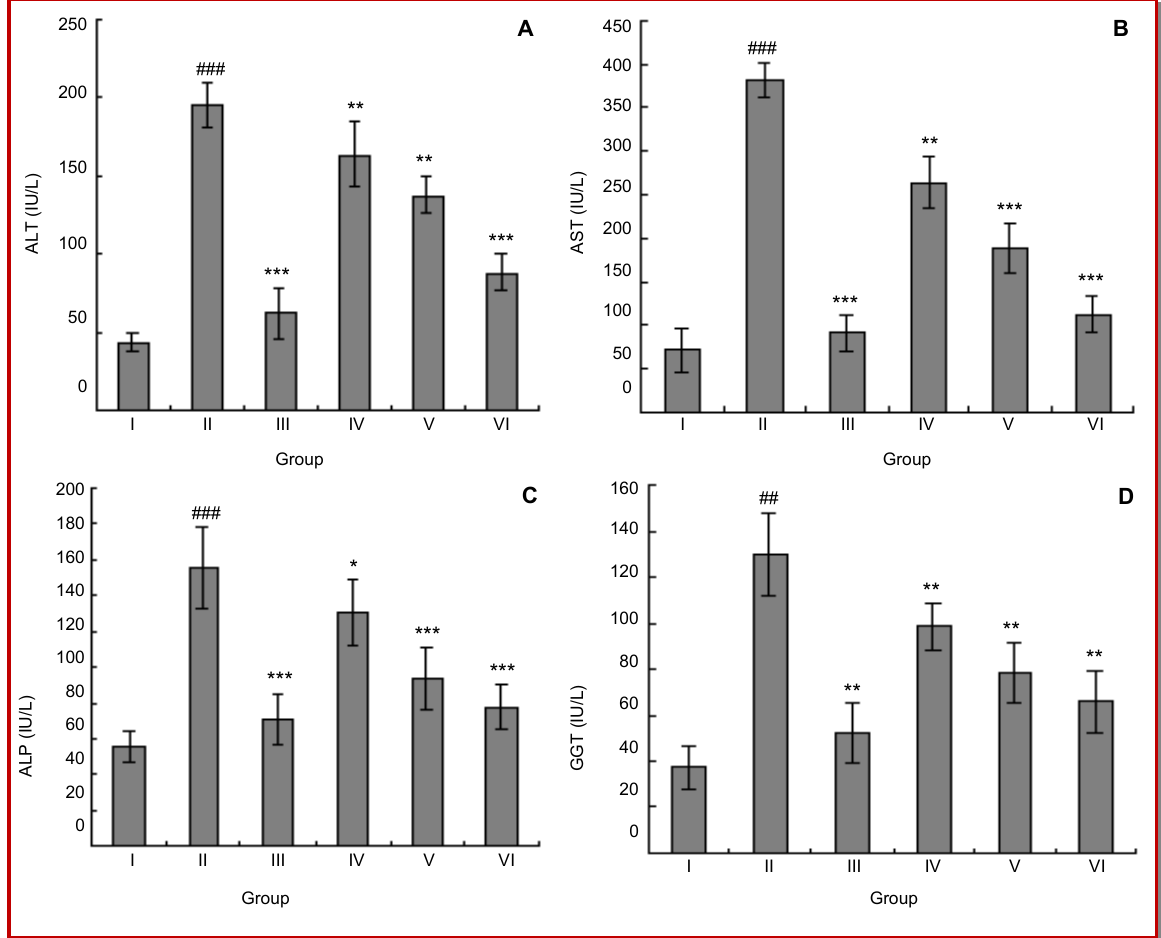
Figure 4: Effect of TFI on the biochemical parameters of CCl 4 -damaged livers of rats. (A) AST; (B) ALT; (C) ALP; (D) GGT. The values have been expressed as the mean values ± standard error of the mean, n=10; # p<0.05, ## p<0.01, ### p< 0.001 versus the nor- mal group; *p<0.05, **p<0.01, and ***p<0.001 compared with the CCl 4 -intoxicated control